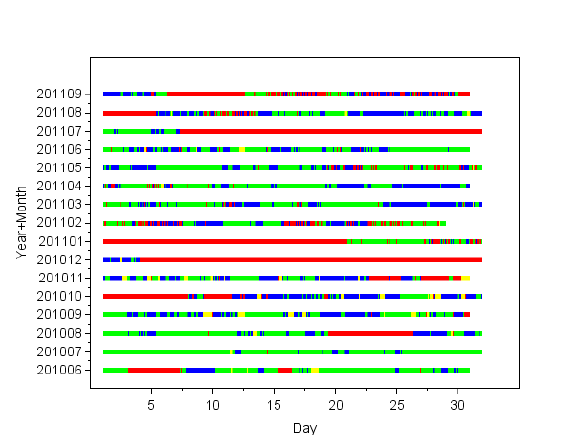
Figure 3. The occurrence of detected areas in individual